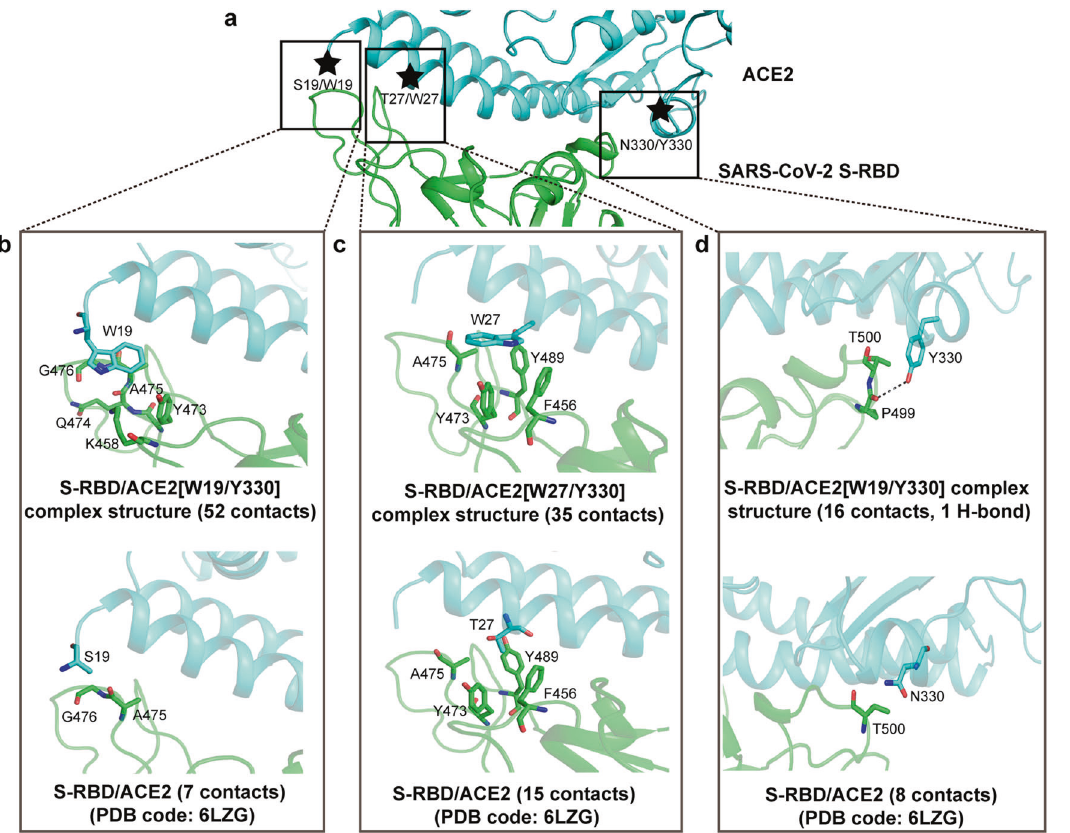
Fig. 3 The superior contributions of the S19W, T27W, and N330Y mutations in ACE2 to SARS-CoV-2 S-RBD binding. a An overview of the binding interface between ACE2 (in cyan) and SARS-CoV-2 S-RBD (in green) to highlight the steric positions of the S19/W19, T27/W27, and N330/Y330 residues, which are marked with stars. The detailed inter-molecule contacts contributed by these three pairs of amino acids are further delineated in ( b ), ( c ), and ( d ), respectively. The residues referred to in the text are shown and labeled. Dashed line indicates H-bond. b Comparison of the inter-molecule interactions mediated by W19 and S19. c Comparison of the inter-molecule interactions mediated by W27 and T27. d Comparison of the inter-molecule interactions mediated by Y330 and N330. The number of van der Waals contacts is listed in